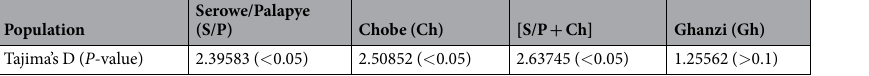
Table 4. Results of the Tajima’s D neutrality test. Tests were performed with DnaSP v6. P-values are provided in brackets.